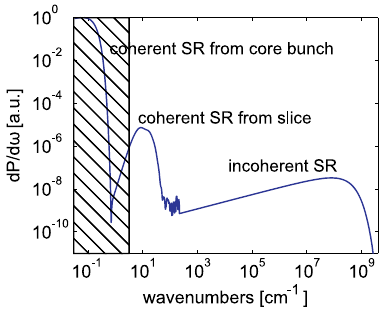
FIG. 3. Simulated spectrum of the synchrotron radiation emit- ted from the sliced electron bunch at the IR beam line. Spectral components within the hatched area are not transported by the beam line.